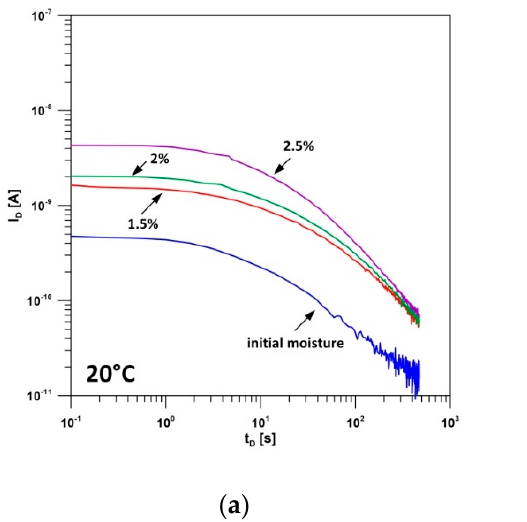
Figure 9. Characteristics of the depolarization current of cellulose–aramid insulation samples with initial thermal ageing at 150 °C and with various moisture: ( a ) depolarization currents in the measurement temperature 20 °C; ( b ) depolarization currents in the measurement temperature 40 °C.